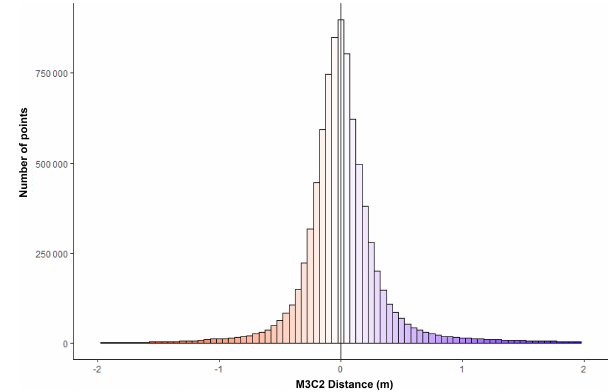
Figure 5. Histogram of M3C2 distance values across the Fjall- sjökull calving face, combining all eight sub-sections together. There is a slight positive skew in distribution (mean 4.31cm). M3C2 distances are cropped here to ± 2m for display purposes, but some values reach ± 10m. Bin widths are 0.05m.